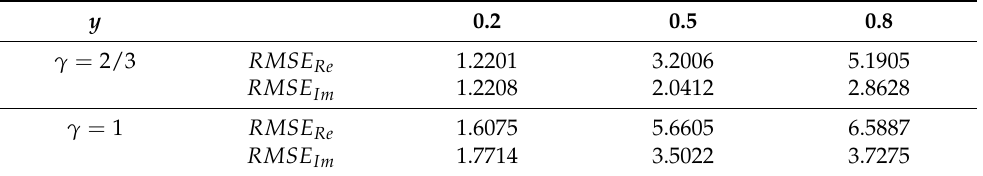
Table 2. Numerical results of Example 2 for different y and γ